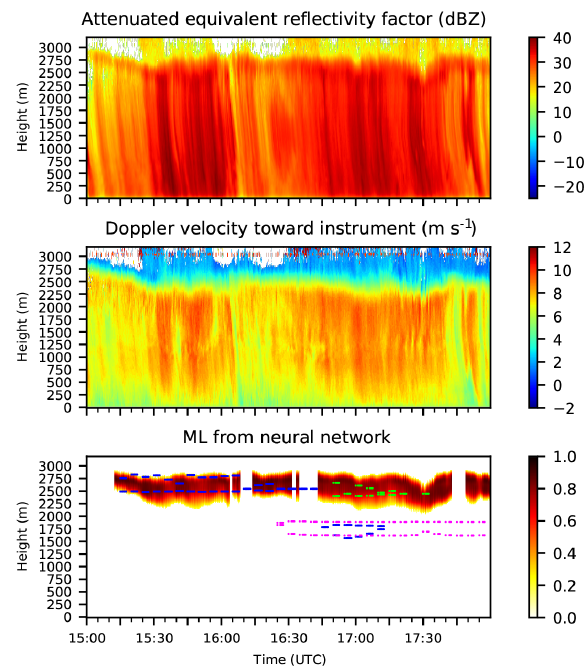
Figure 10. ZEA, VEL, and ML detected by the NN for Hohen- peißenberg on 10 August 2017 from 15:00 to 18:00UTC. The dashed lines indicate the top and bottom of the ML heights de- tected by three weather radars: green represents Isen, blue repre- sents Memmingen, and pink represents